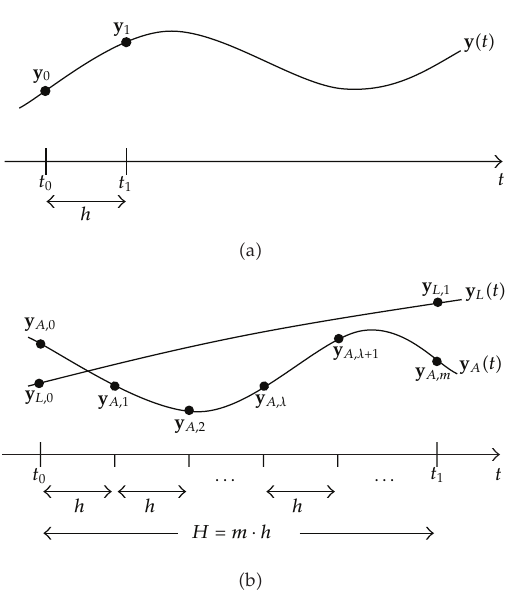
Figure 2: (cid:2) a (cid:3) Single step in a standard Runge-Kutta integrator. (cid:2) b (cid:3) Micro- and macrosteps in a multirate Runge-Kutta integrator (cid:8) 16 (cid:9)